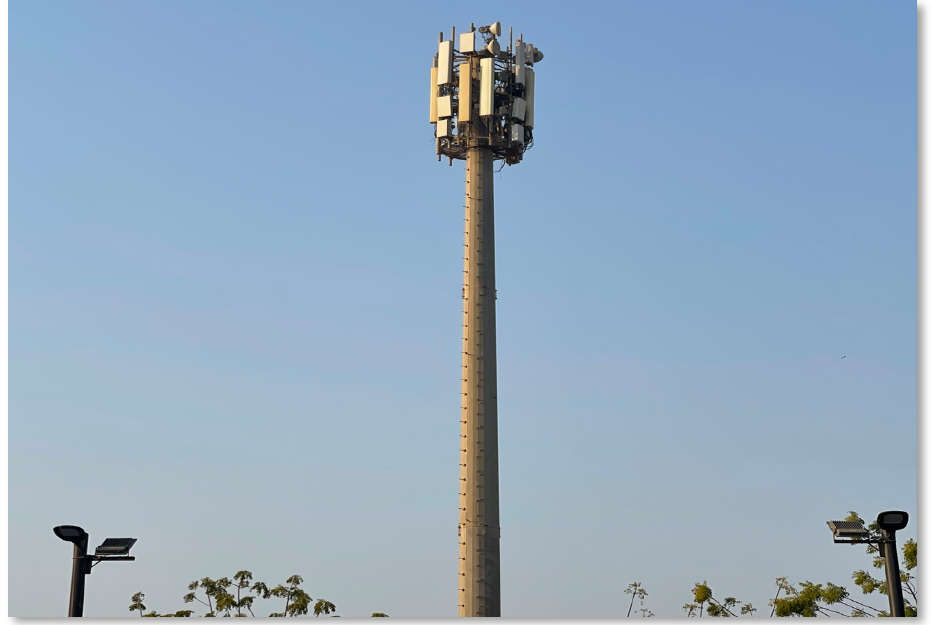
Figure 3. Photograph of macro site shared by three MNOs.